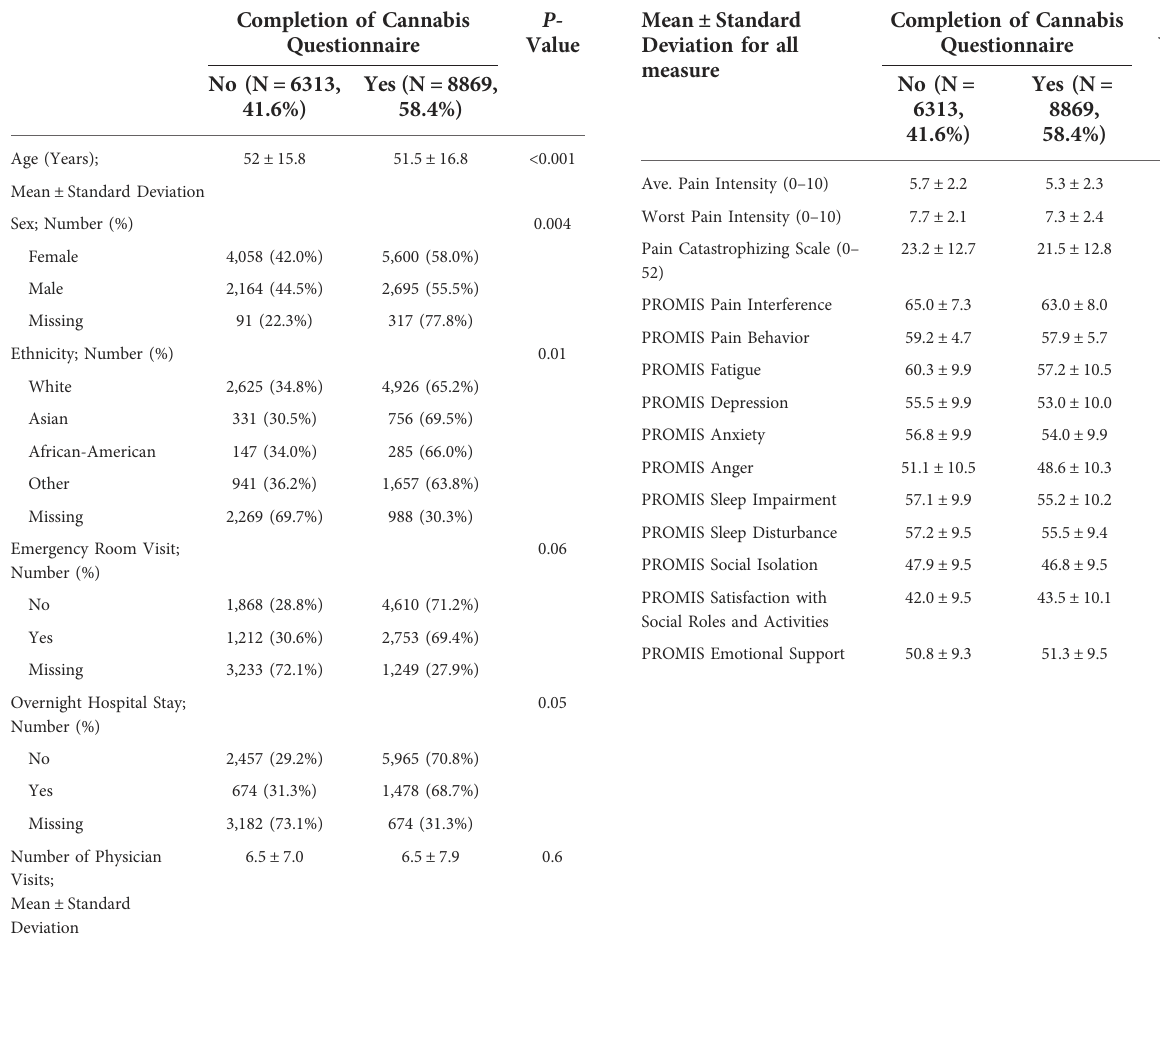
TABLE A2 Pain intensity and PROMIS measures based on completion of cannabis